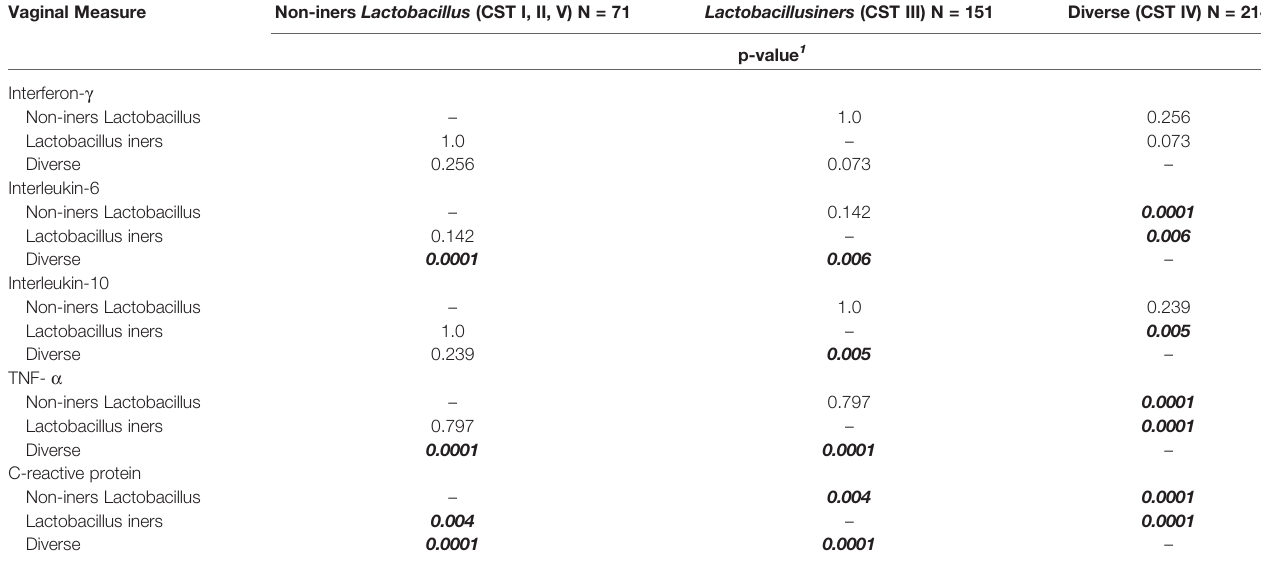
TABLE 2B | Vaginal C-reactive protein and Cytokine Concentrations According to CST